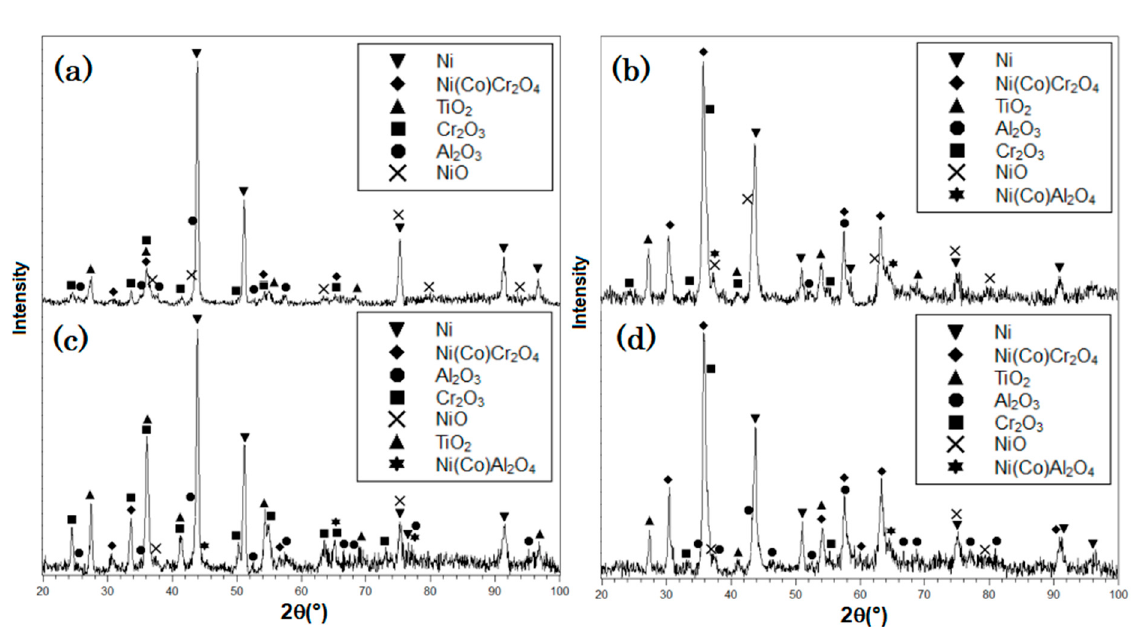
Figure 6. XRD diffractograms for 180 cycles. ( a ) MAR-M246(Ta) at 900 ◦ C, ( b ) MAR-M246(Ta) at 1000 ◦ C, ( c ) MAR-M246(Nb) at 900 ◦ C, and ( d ) MAR-M246(Nb) at 1000 ◦ Table 2. Oxidation products obtained by XRD diffractograms for 180 cycles.